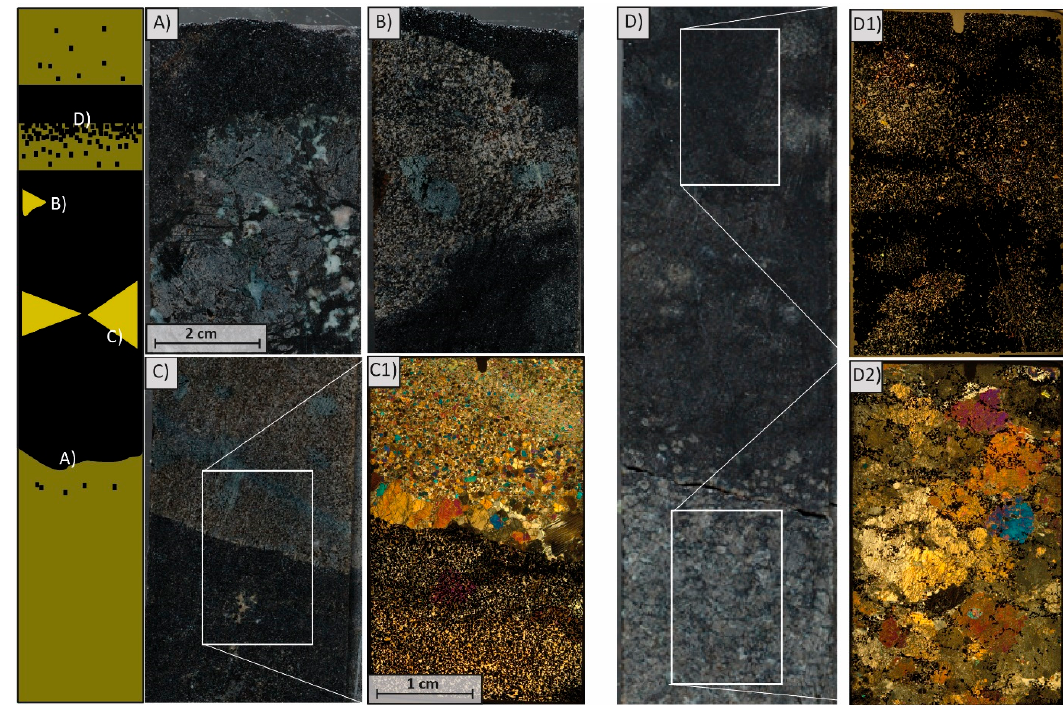
Figure 4. Drill core and related cross-polarised (xpl) thin section images of chromitite layers and associated silicate UG2 subunit contact zones. Scale bar in ( A ) applies to ( B – D ); scale bar in ( C1 ) applies to ( D1 ) and ( D2 ). High interference colours result from thin section thicknesses > 35 µm. ( A ) Main Seam–Lower Pegmatoid transition; ( B ), ( C ) Main Seam–Lower Split contact; ( C1 ) xpl thin section image of Main Seam–Lower Split contact, sample 310.90a; ( D ) Leader Seam–Upper Split transition; ( D1 ) xpl thin section image of Leader Seam, sample 310.00a; ( D2 ) xpl thin section image of Leader Seam–Upper Split transition, sample 310.00b.